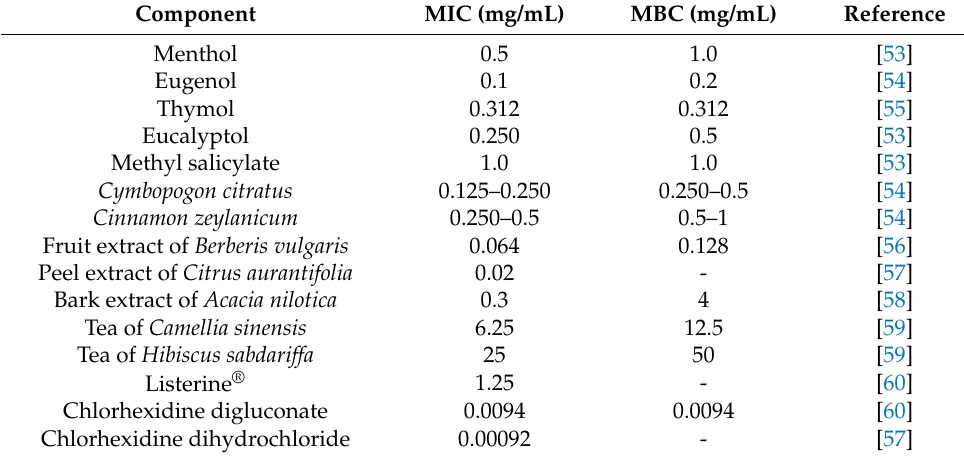
Table 2. Minimum inhibitory concentrations (MIC) and bactericides (MBC) of chlorhexidine diglu- conate, Listerine ® , essential oils and their derivatives against planktonic cells of S. mutans